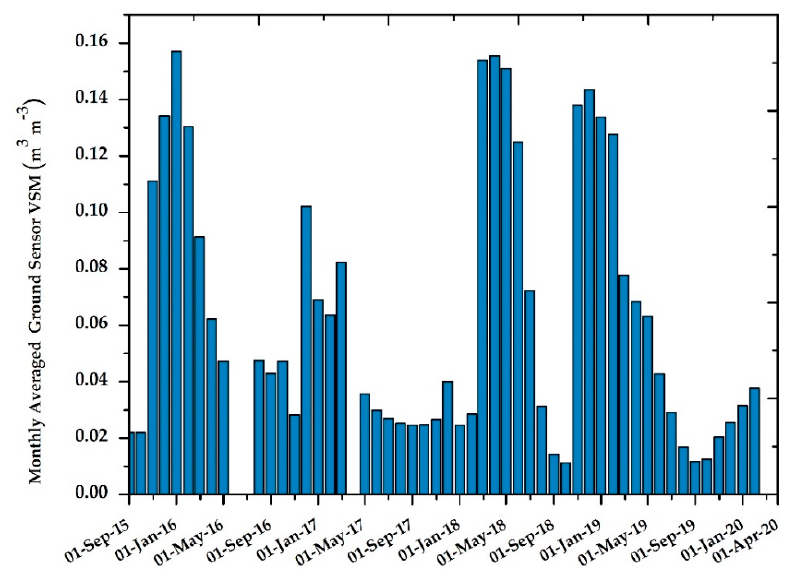
Figure 5. Ground station VSM data (monthly average) over validation test site (36 km × 36 km) (showing wet–dry months).